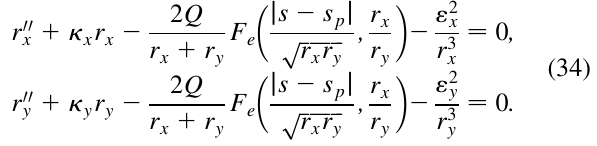
[Eq. (33)] for the elliptical e =r x y